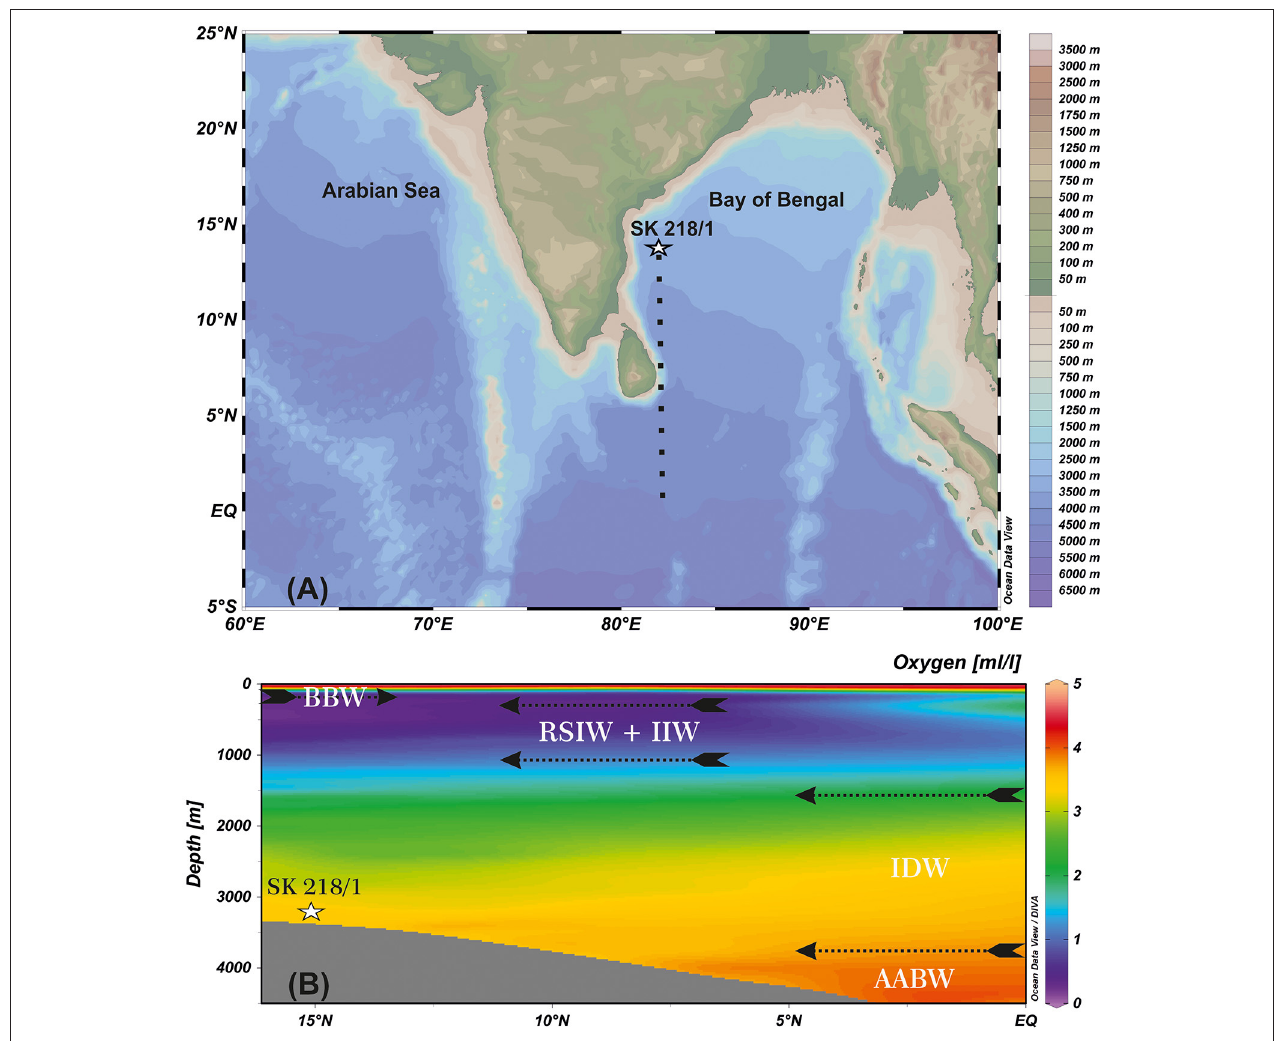
FIGURE 1 | (A) Map showing the location of studied core (SK 218/1) in the Bay of Bengal (BoB). (B) Oxygen (ml/L, color shading) depth (m) latitude section and vertical structure of water masses in the BoB [N–S cross-section represented by black dashed line in (A) ]. Map source Ocean Data View (ODV; Schlitzer, 2015). BBW, Bay of Bengal Water; RSIW, Red Sea Intermediate Water; IIW, Indonesian Intermediate Water; IDW, Indian Deep Water; AABW, Antarctic Bottom Water.